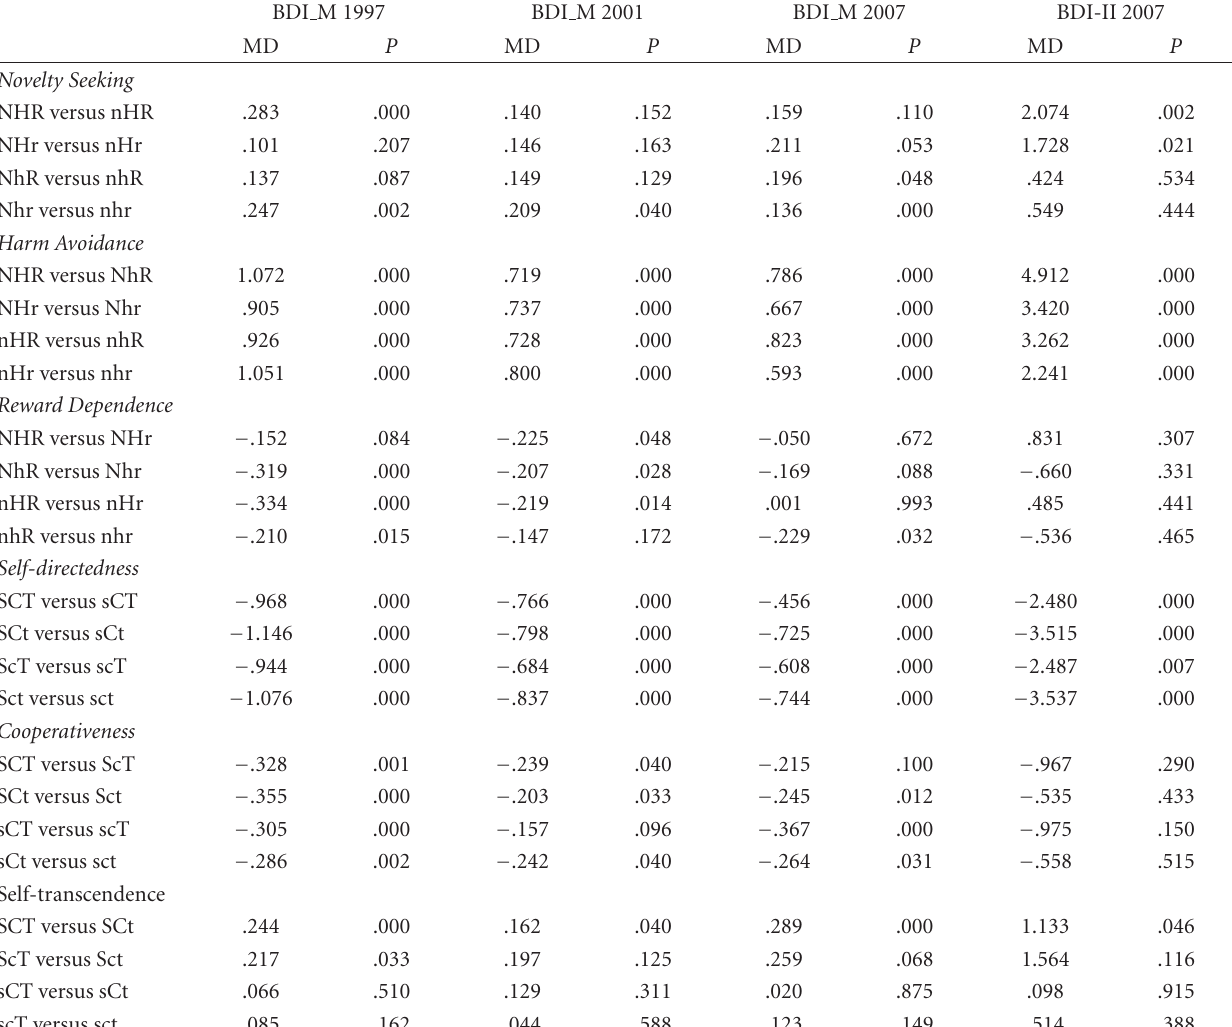
Table 2: Pairwise comparison of depressive symptom scores between groups of various temperament and character